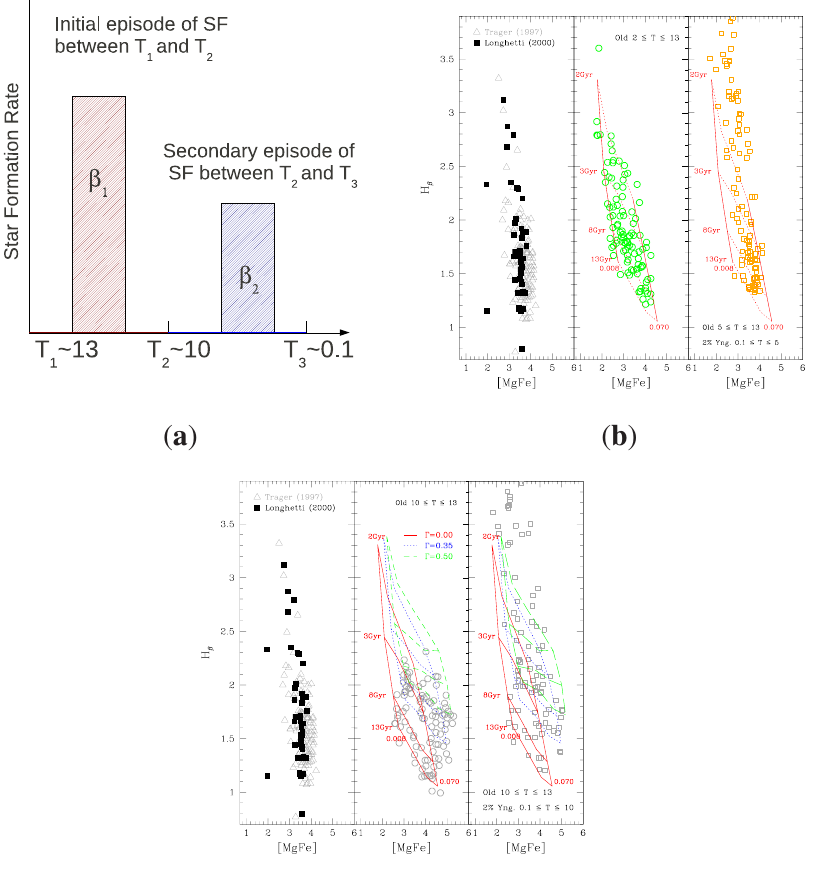
Figure 5. ( a ) Artistic view of the SFH in the model galaxies: an old dominant episode of intensity I whose age is comprised between T = β = 13 and T = 10 Gyr ago, followed B 1 1 2 by another episode of intensity I occurring at any arbitrary age comprised between = β B 2 T = 10 and T = 0.1 Gyr ago; the intensities of the two SF episodes can randomly vary; 2 3 vs. [MgFe] plane. Left Insert : ( b ) Observational data and MonteCarlo simulations in the H β The normal galaxies of [60] indicated by the open triangles and the shell- and pair-galaxies of [74] indicated by the filled squares. Note the smooth and nearly vertical distribution of both groups of galaxy. Central Insert : MonteCarlo simulations for the set of parameters =13 Gyr, T =2 Gyr, β =1, no additional bursts of star formation. The metallicity is T 1 2 1 randomly chosen in the interval 0.008 0.07, no enhancement of α -element is considered Z ≤ ≤ ( Γ =0). The solid lines are two SSPs with Z =0.008 (left) and Z =0.07 (right). Four values of α the age, i.e. , 2, 3, 8 and 13 Gyr are marked. The thin dotted lines are the loci of constant age. The very large age range is required to get full coverage of the range in H spanned by the β data. Right Insert : MonteCarlo simulations according to the recipe: T =13 Gyr, T =5 Gyr, 1 2 random burst of star formation activity at a time in the interval 0.1 5, the same interval T 1 ≤ ≤ for the minimum and maximum metallicity and the same Γ as in the previous simulations. α The percentage of the young population is β =0.02. The bulk population formed in the time 2 interval T to T obeys the universal law of metal enrichment. All other symbols have the 3 2 same meaning as in the Central Insert. ( c ) The same as in panel ( b ) but with the enhancement of alpha -elements as indicated. Reproduced with permission from [57]. Copyright 2004 John Wiley &